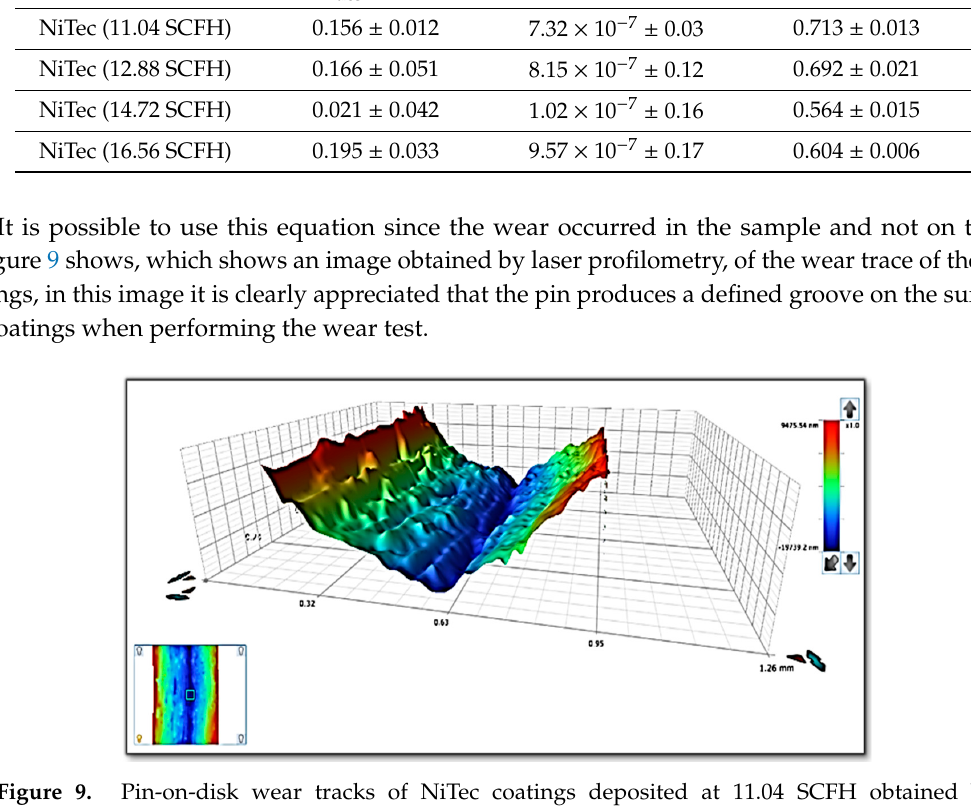
Table 5. Pin on disk test parameters of NiTec coatings.